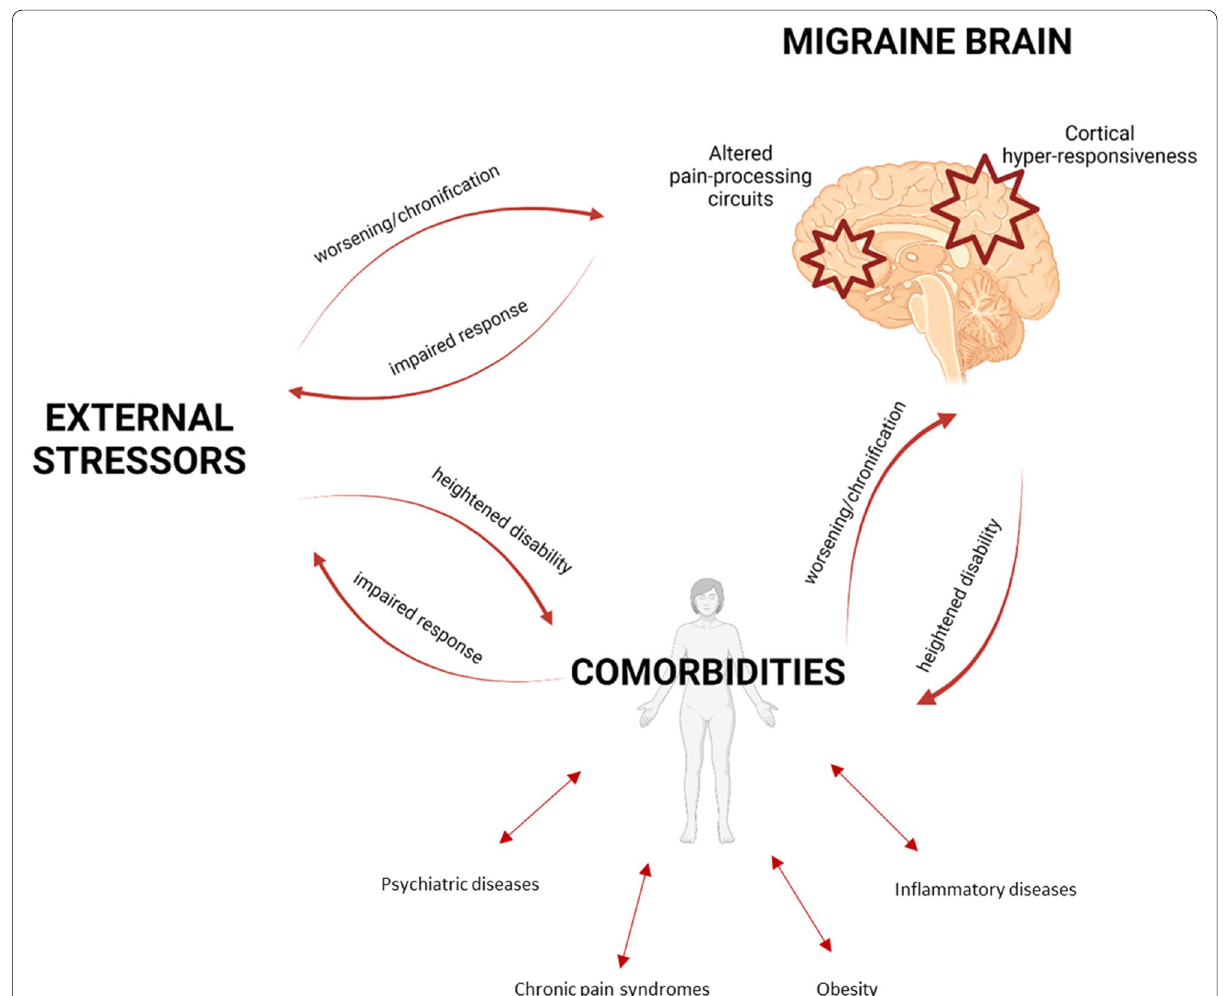
Fig. 3 The vicious cycle of migraine comorbidities and stressors. Created with https:// biore nder.